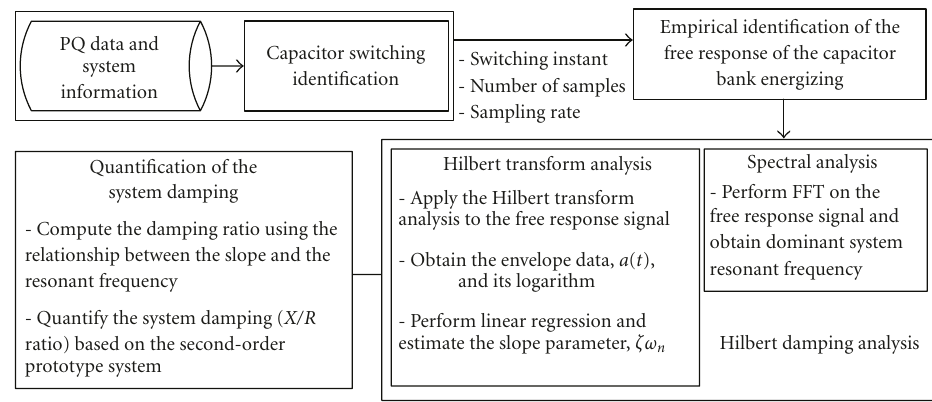
Figure 2: Data flow and process diagram of the system damping